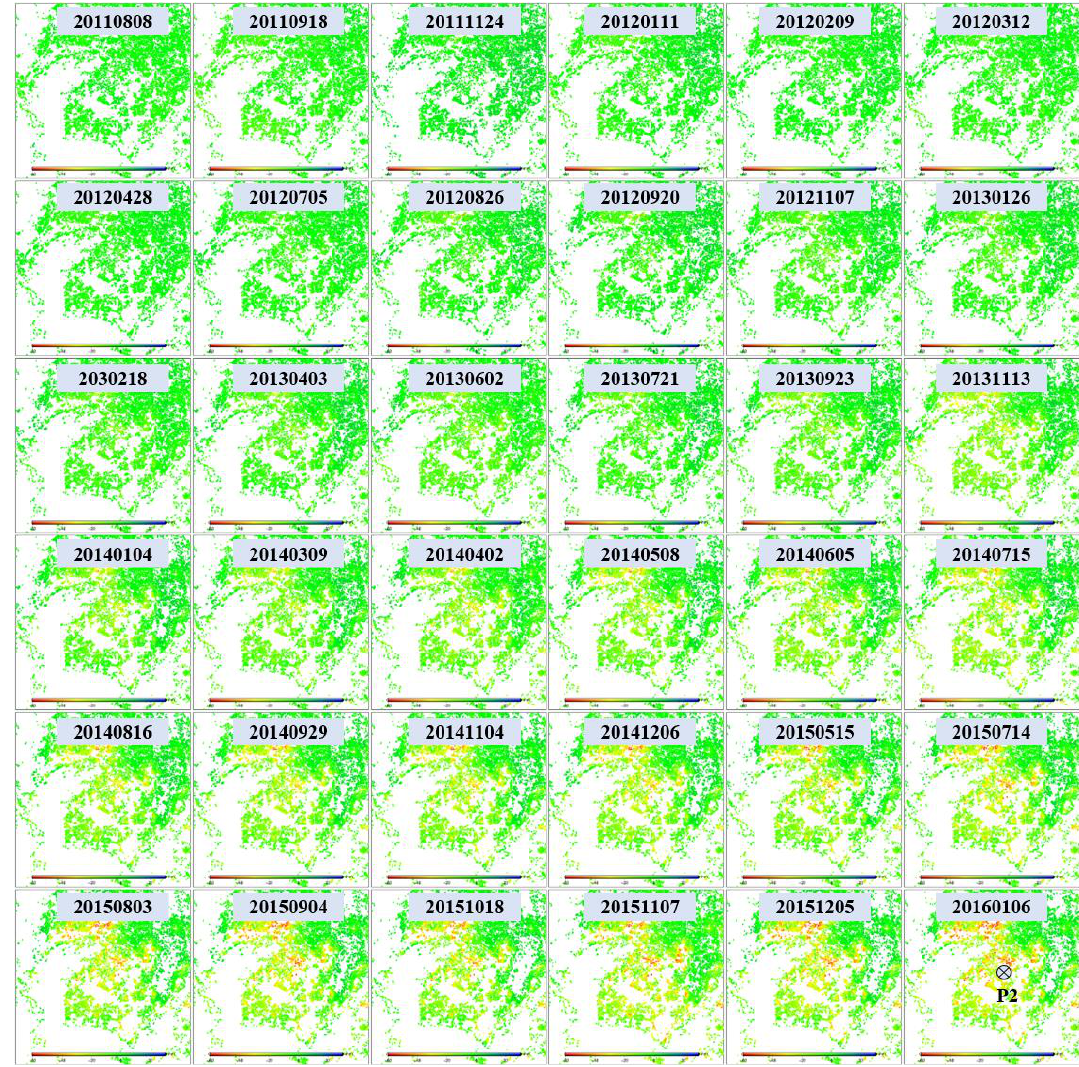
Figure 14. Time series deformation in Xishan (marked with black rectangles in Figure 5) observed from X-band COSMO-SkyMed images. The time series deformation at point P2 will be extracted for further analysis.